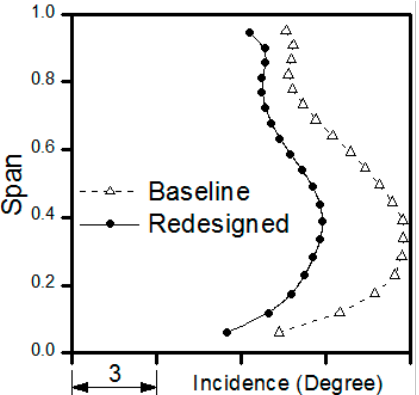
Figure 17. Spanwise distributions of the incidence for the baseline and redesigned stator 5 (near the